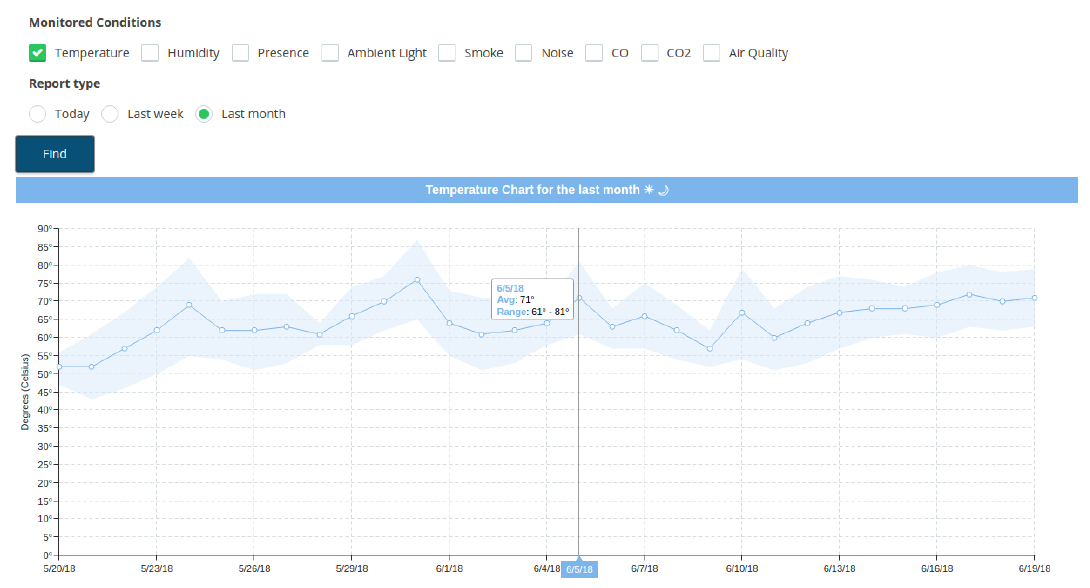
Figure 10. Monthly ambient